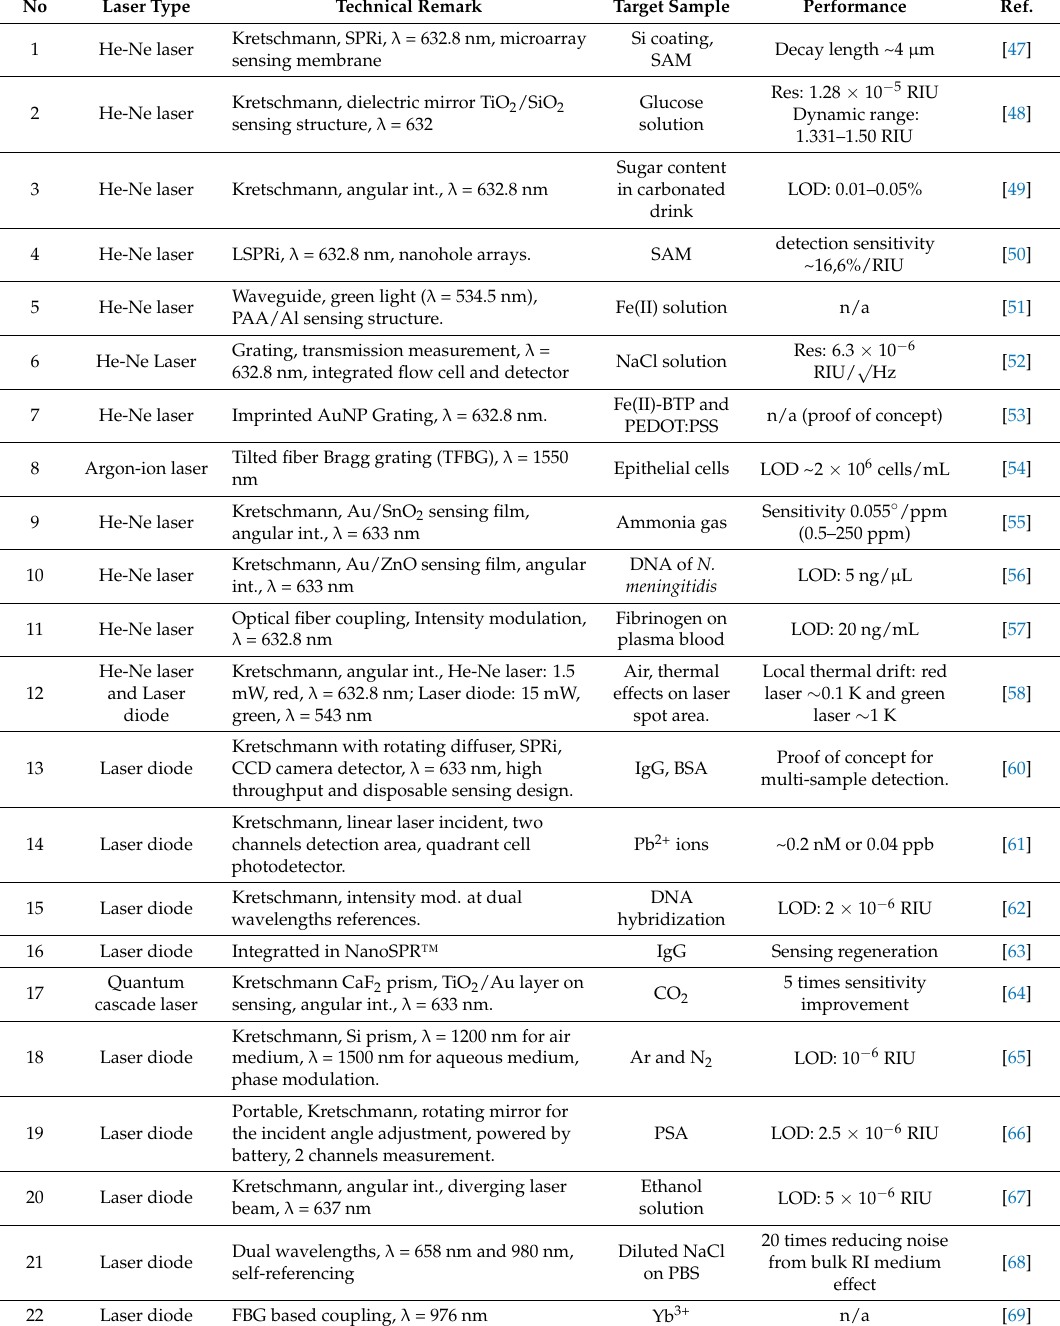
Table 3. The summary of SPR sensor development with laser